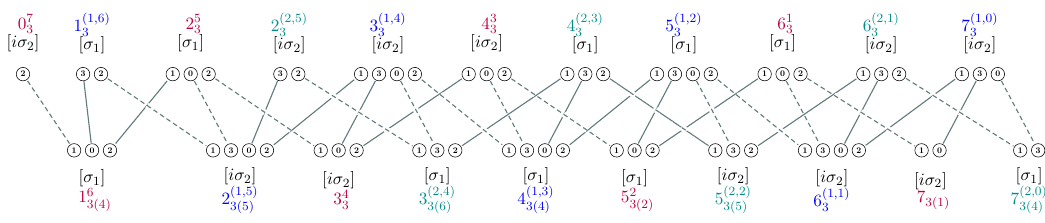
Figure 3 . T -duality chain of S(olitonic)-branes.